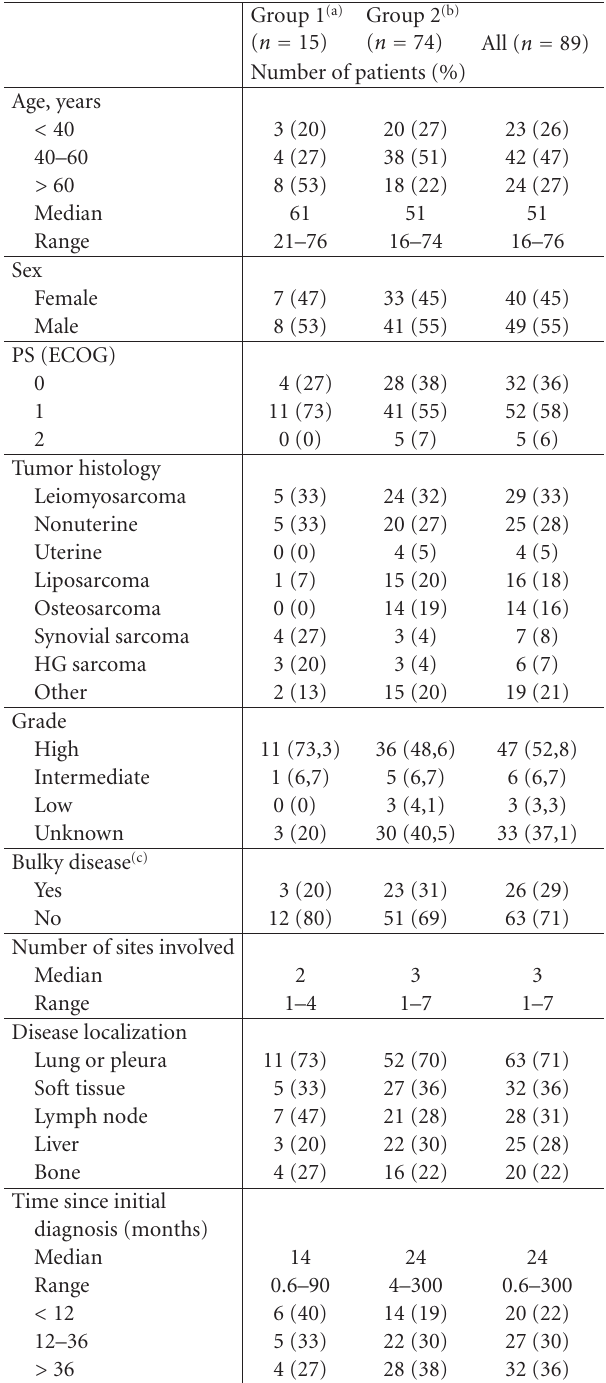
Table 1: Patient characteristics at baseline. PS: performance status; ECOG: eastern cooperative oncology group; HG: high grade.